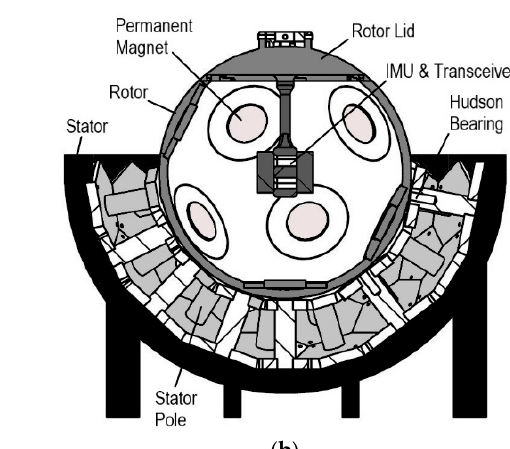
Figure 10. Complete PMSSM assembly: ( a ) Photograph and ( b ) Cross-sectional schematic.